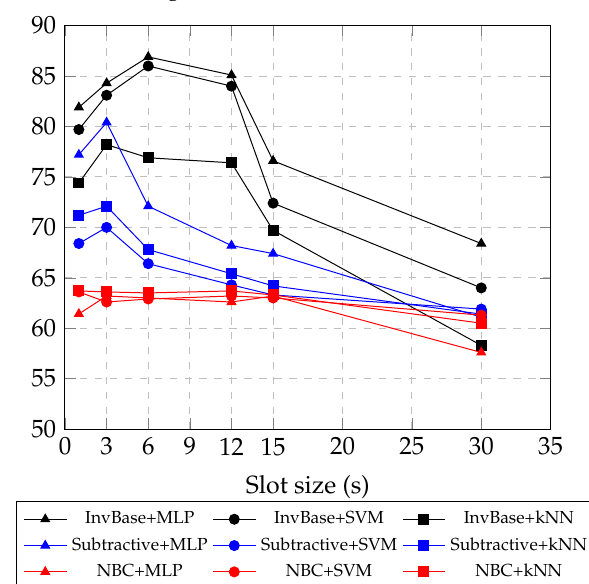
Figure 4. Arousal classification accuracies obtained using different slot sizes in InvBase, subtractive, and NBC